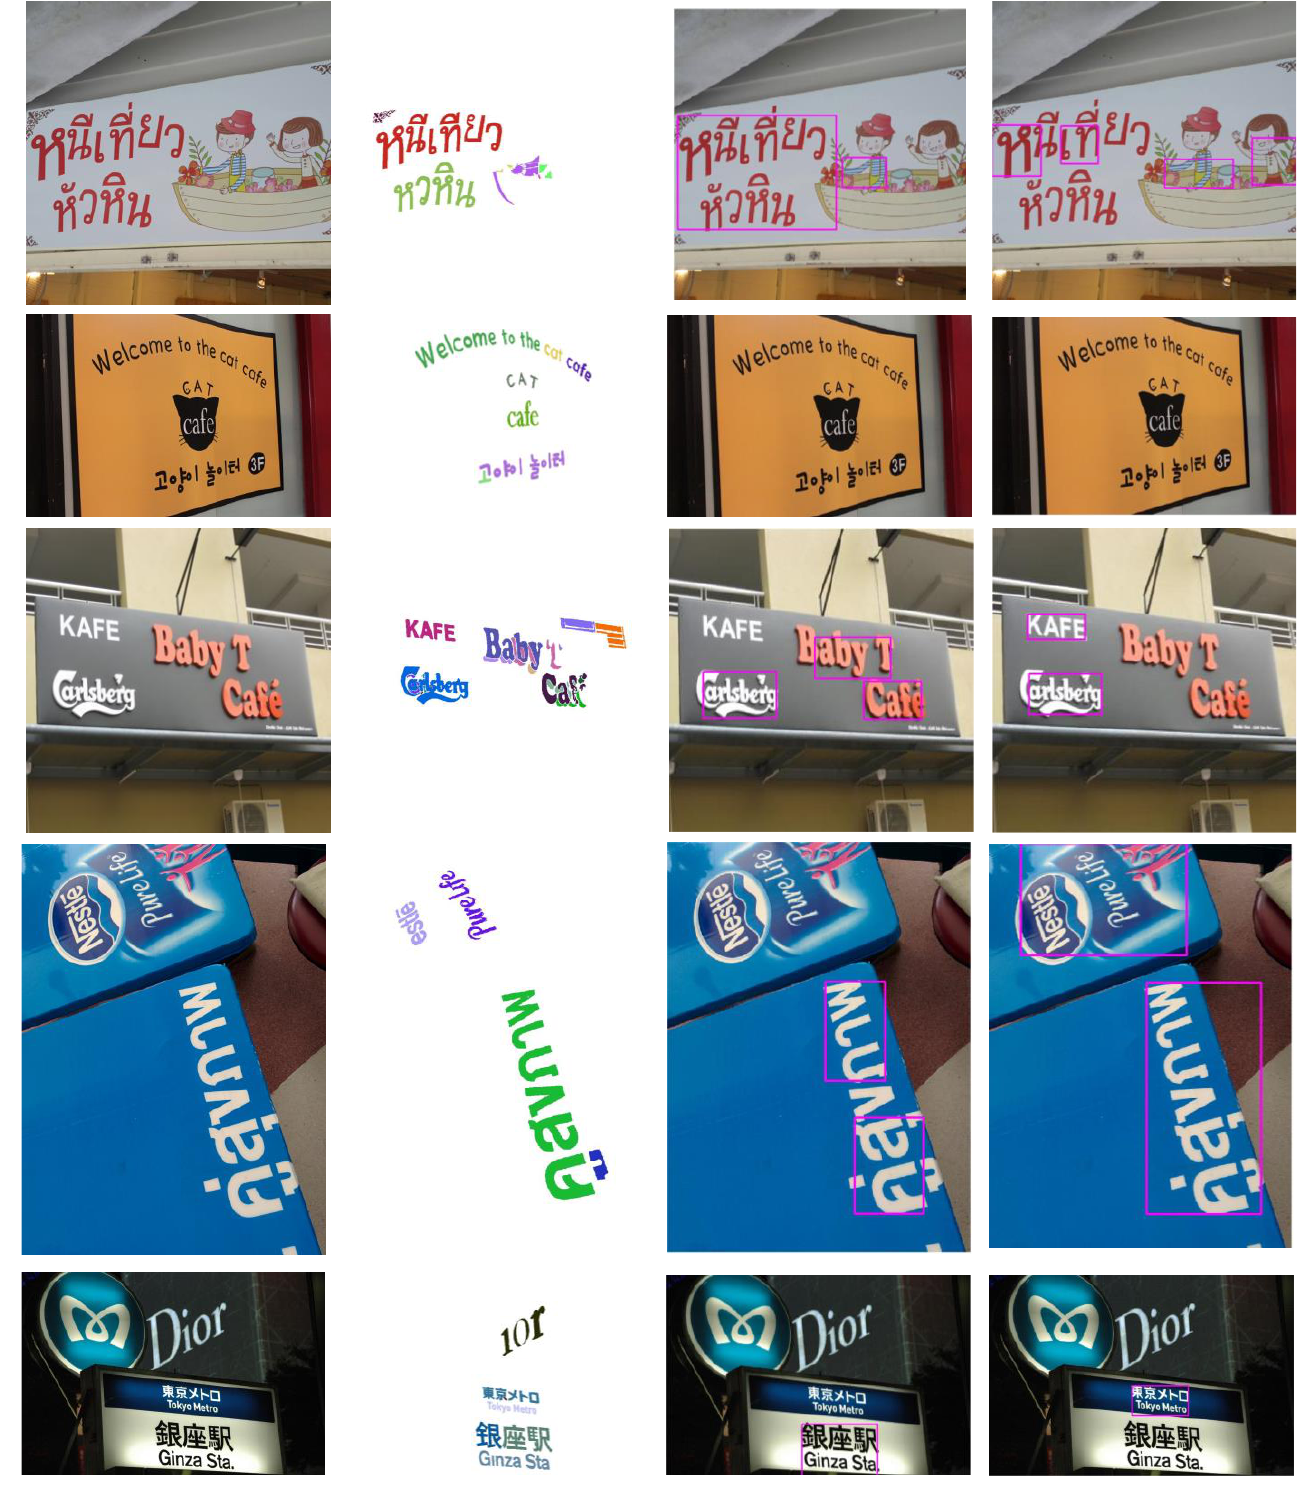
Figure 10. Example of experimental results (continued). From left to right, original scene images, text localization result from the proposed method (different colors are corresponding to different text cluster), the result (bounding box) from H. Chen method [10] using dark texts in brighter background ,the result from H. Chen method using bright texts in darker